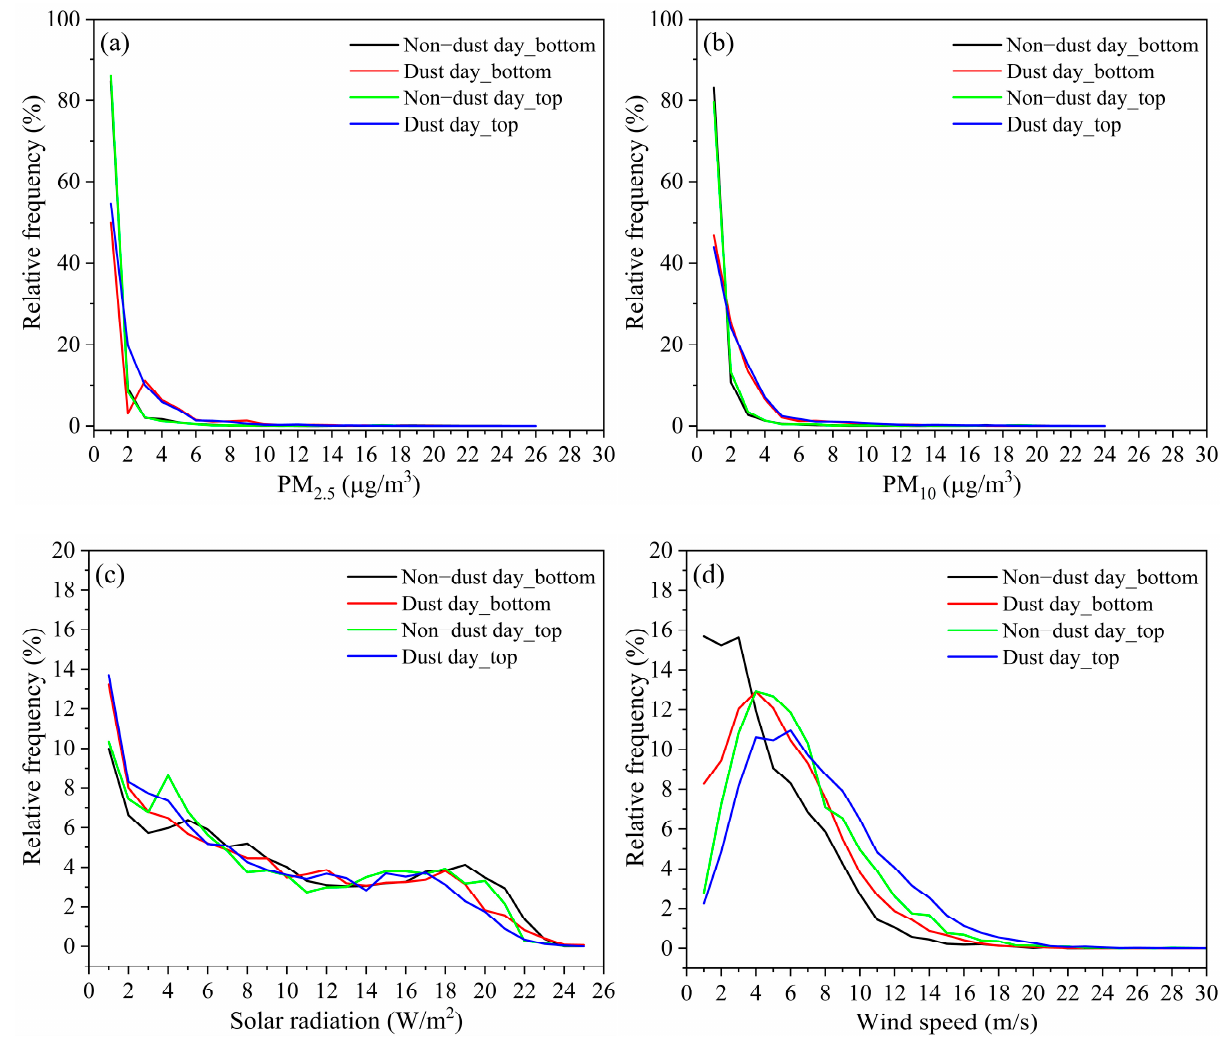
Figure 12. Relative distributions of PM 2.5 concentration ( a ), PM 10 concentration ( b ), SR ( c ), and WS ( d ) during the observation in the TD ( a , b ): the abscissa 1–26 represents 0–10, 11–20,......251–260 µg·m − 3 ; ( c ): the abscissa 1–25 represents 1–50, 51–100,......1201–1250 W·m − 2 ; and ( d ): the abscissa 1– 34 represents 0–0.5, 0.6–1.0,......16.6–17.0 m·s − 1 ).